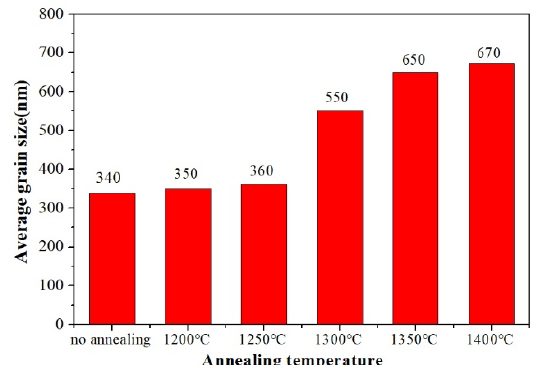
Figure 4. The grain size of sintered BZT ceramics by SPS at 1300 ° C and annealed BZT ceramics at different temperatures.